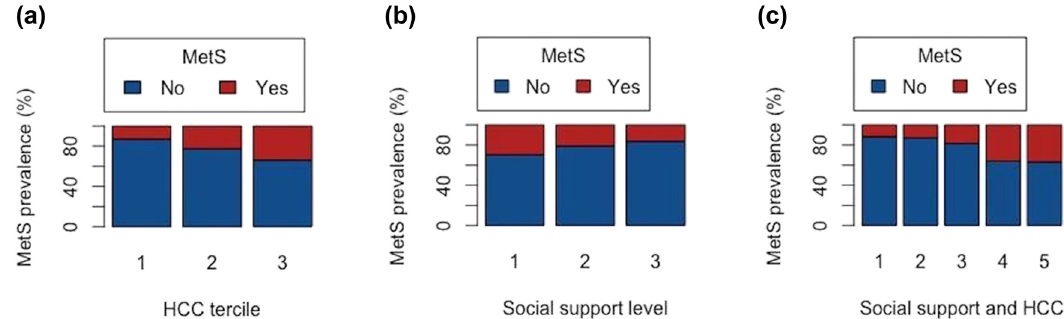
Figure 1: The prevalence of metabolic syndrome ( % ) according to HCC ( a ) , social support level ( b ) terciles and fi ve groups based on both HCC tercile and social support level ( c )